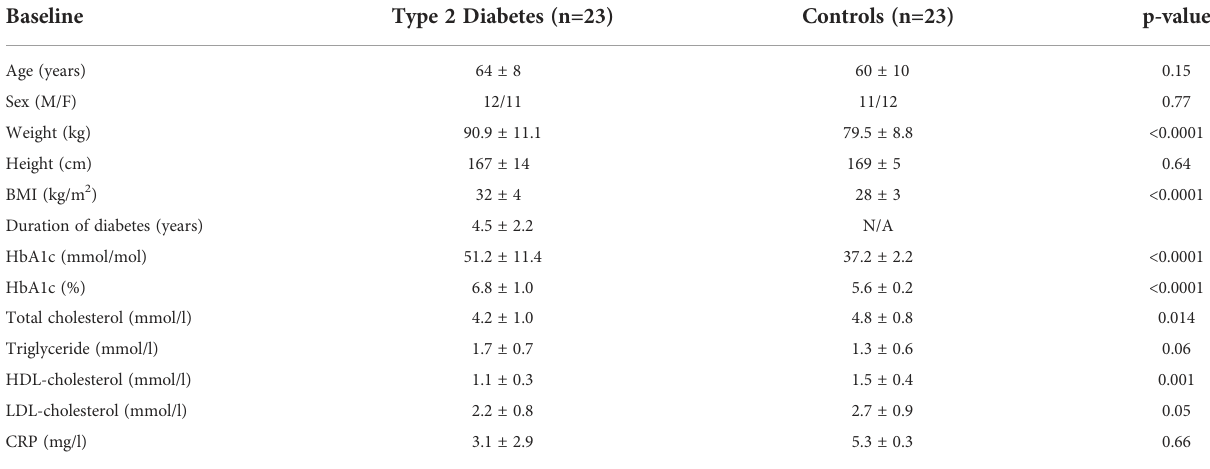
TABLE 1 Demographic and clinical characteristics of the study